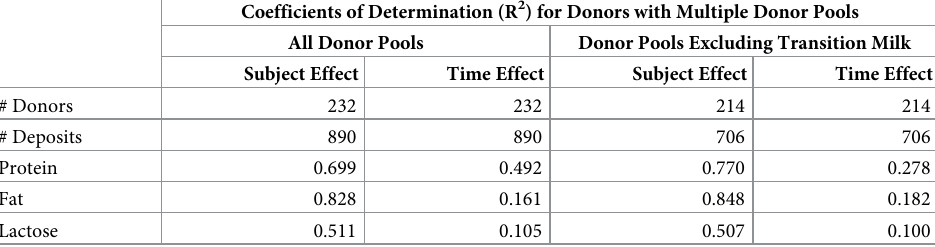
Table 2. Impact of subject-effect versus time-effect on predicting macronutrients in donors with multiple donor